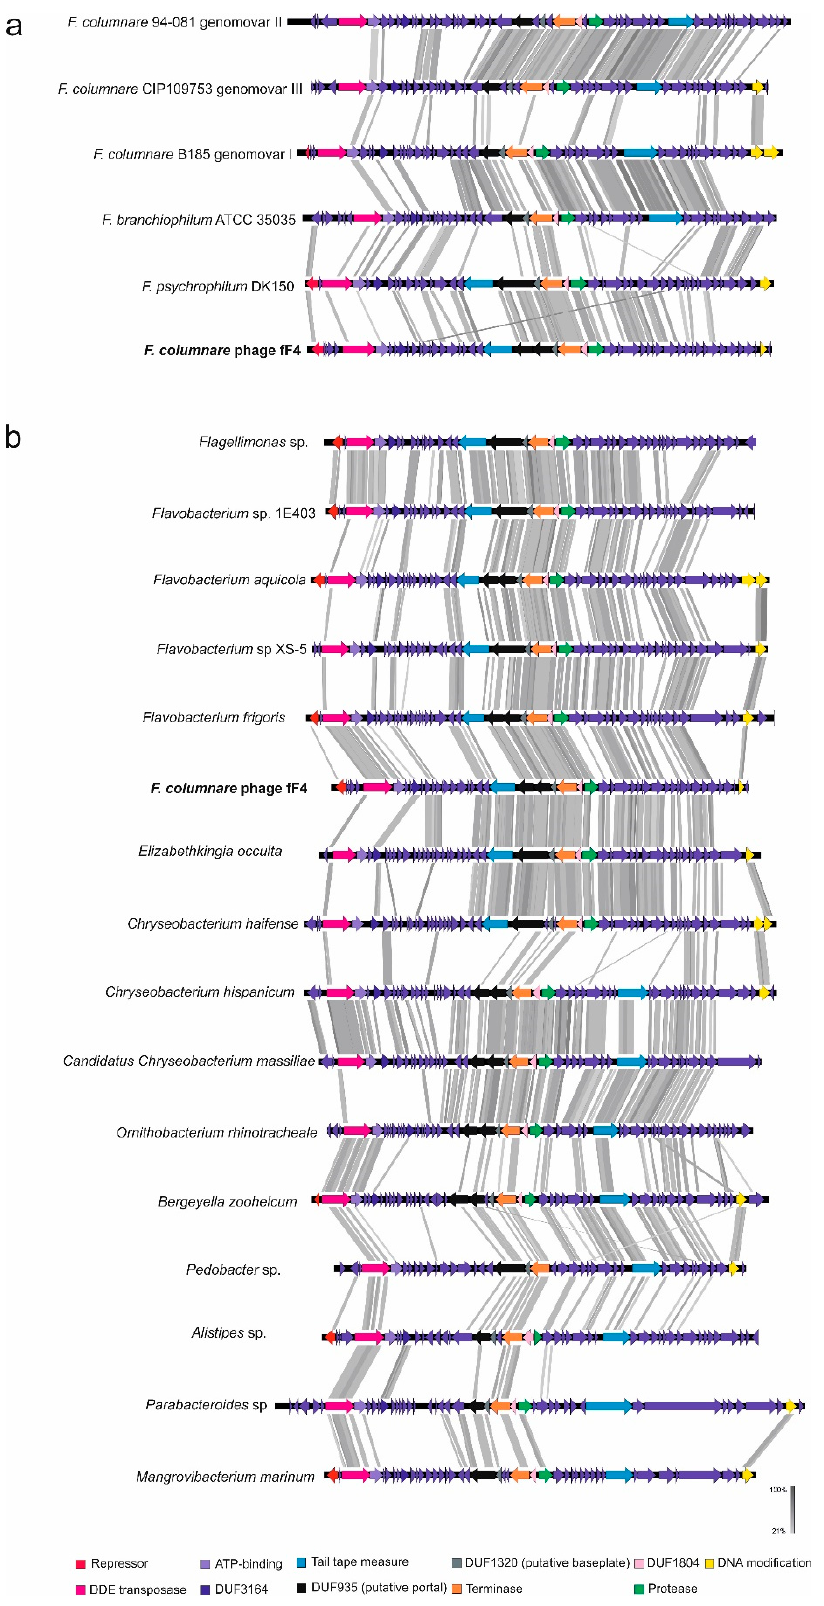
Figure 3. ( a ) Similarities between phage fF4 and the putative fF4-like prophages in the fish pathogen species of Flavobacterium . ( b ) The similarities between putative fF4-like prophages in the di ff erent species of Bacteroidetes (including phage